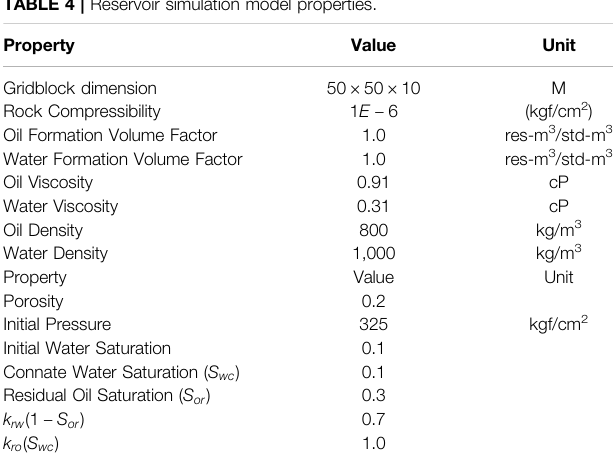
TABLE 4 | Reservoir simulation model properties.